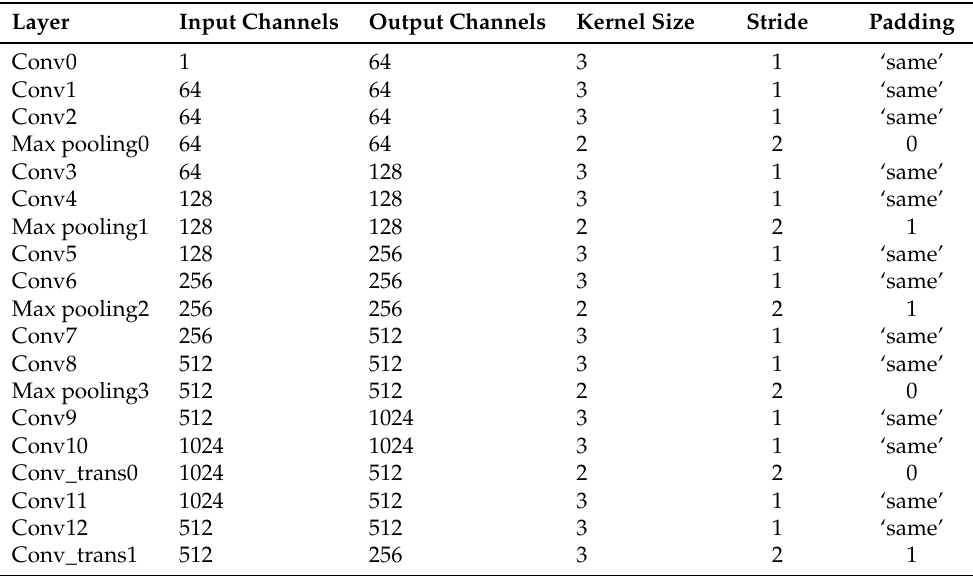
Table 2. Specifications of the